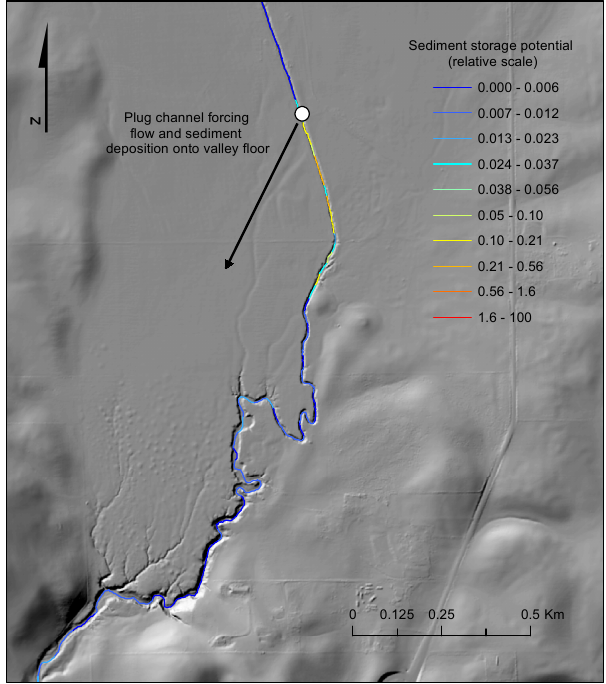
Figure 11. Example in the Cayetano Creek tributary showing how sediment storage potential can help identify locations to reconnect channels to